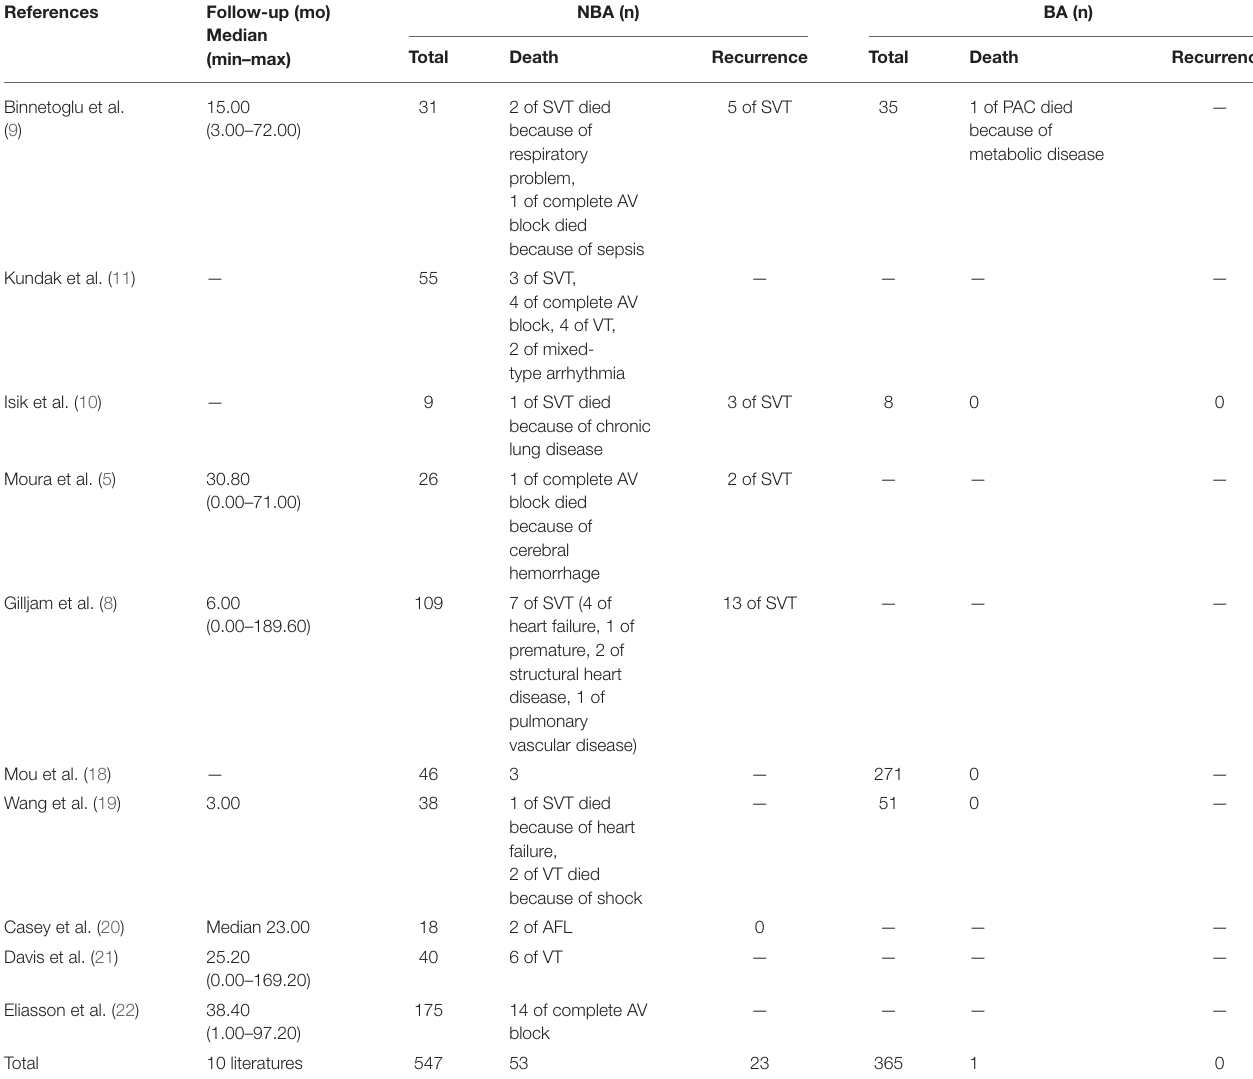
TABLE 4 | Summary of other NA study referring to the main